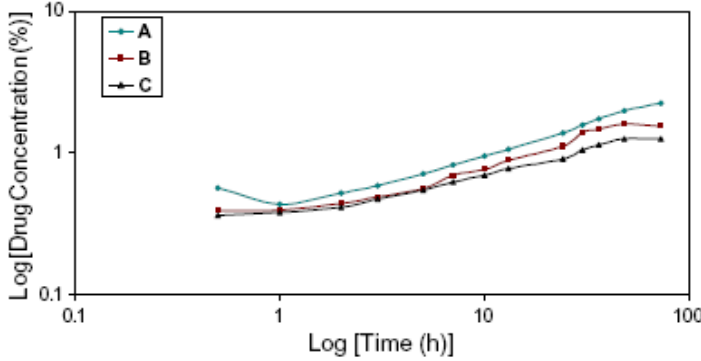
Figure 25. Indomethacin release profiles of HMPC tablets in SIF at 37